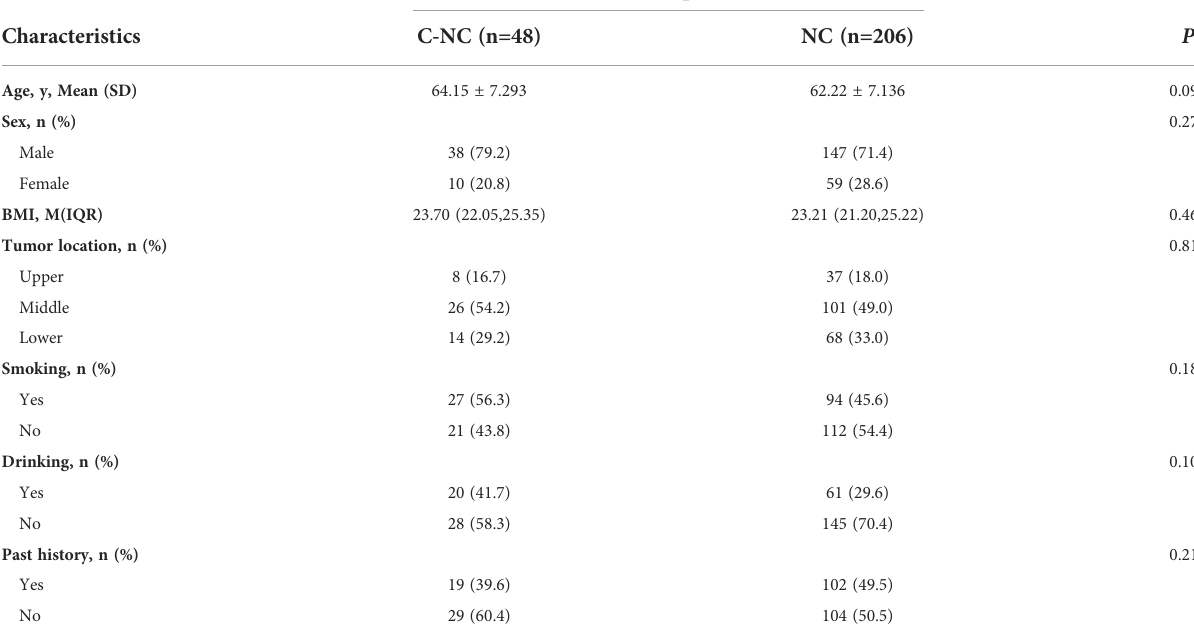
TABLE 2 Clinical characteristics of the patients with ESCC treated with different neoadjuvant therapies.